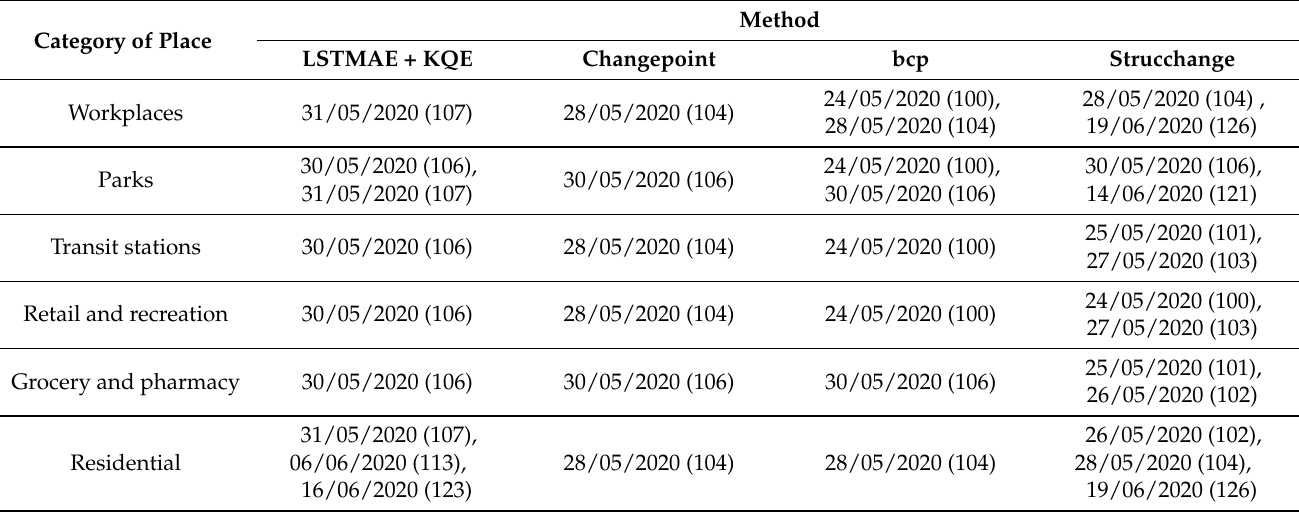
Table 3. A comparison of the date of occurrence and location of the change-points that were detected by the